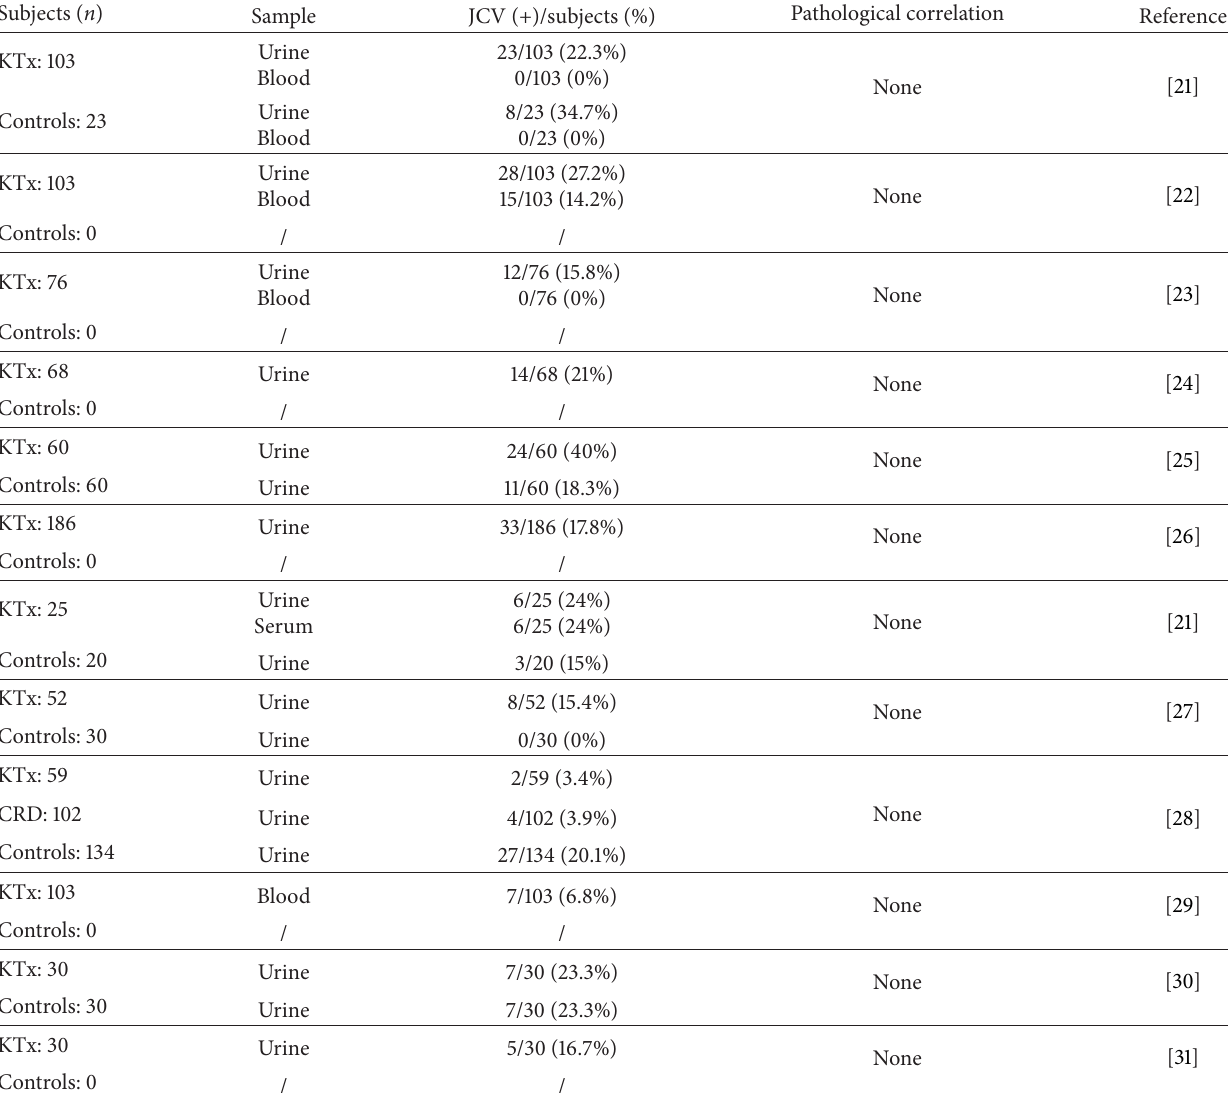
Table 1: Studies on JCV and kidney